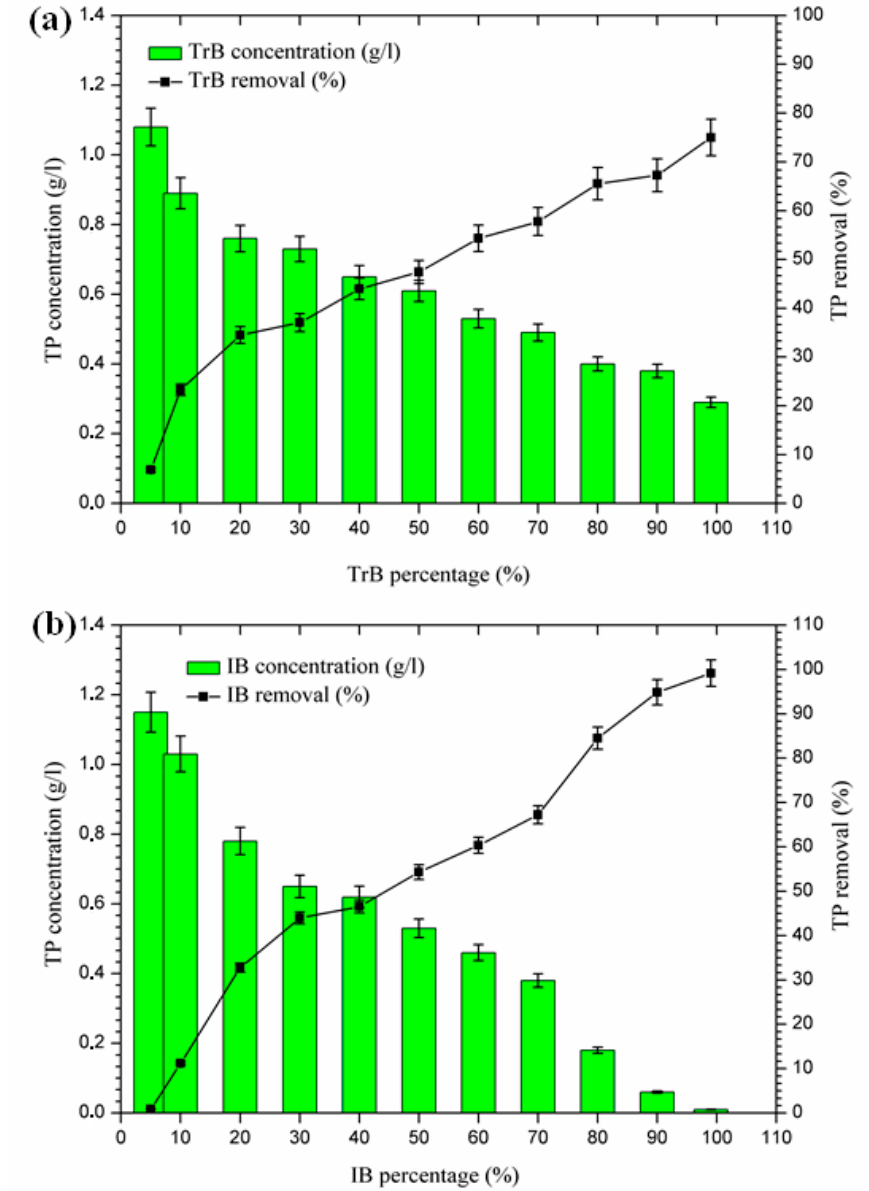
Figure 8. ( a ) Concentration and percentage of TP removed by TrB; ( b ) concentration and percentage of TP removed by IB.